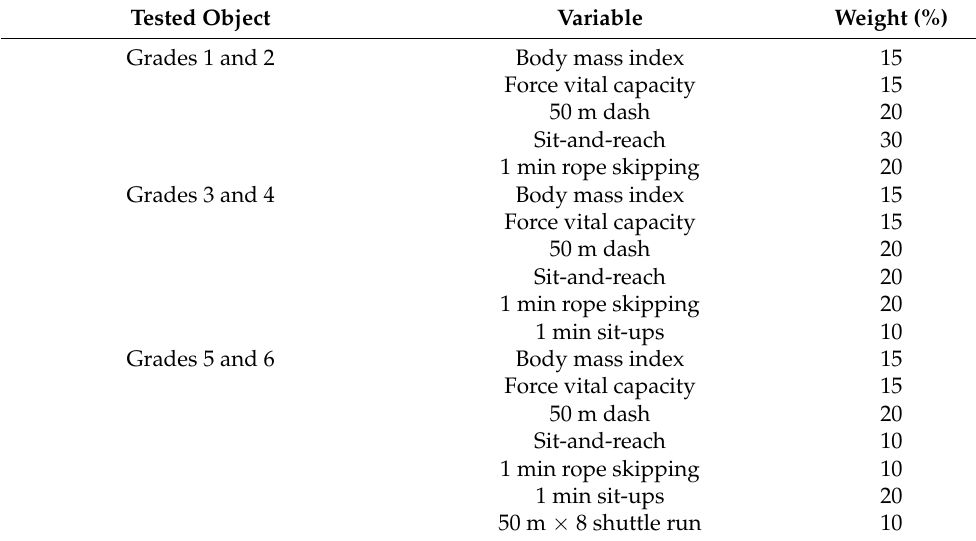
Table 1. Variable and